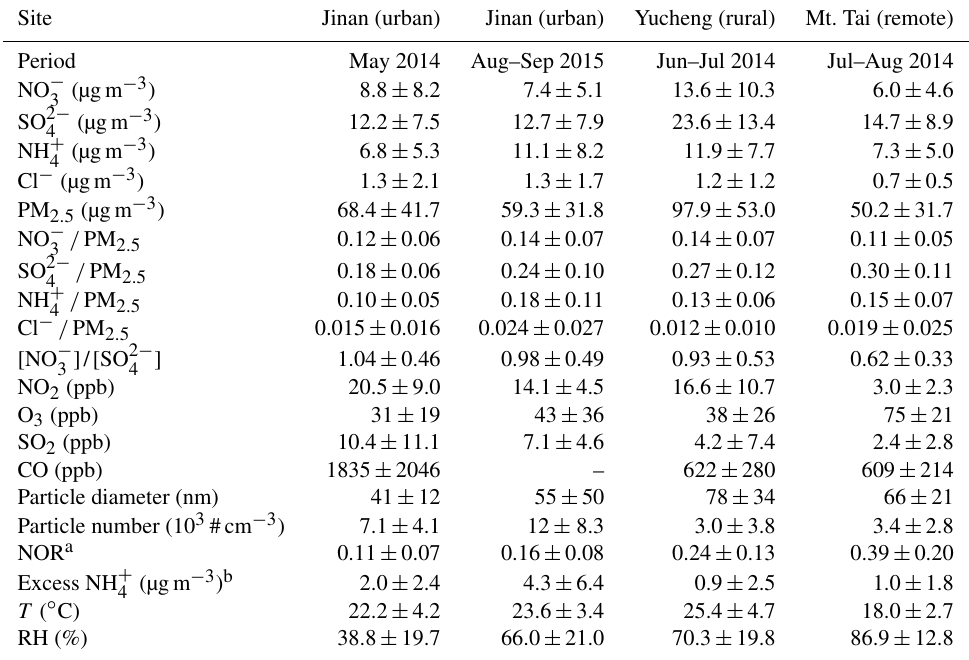
Table 1. Statistics (average ± standard deviation) of the measured aerosol chemical properties, trace gases and meteorological conditions in urban Jinan, rural Yucheng and Mt. Tai.